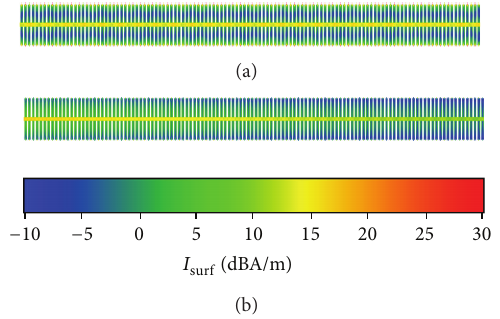
Figure 5: 120-element array: surface current distribution obtained by SFX method at 𝑓 = 6.5 GHz. All “on” (a) and all “off” configuration